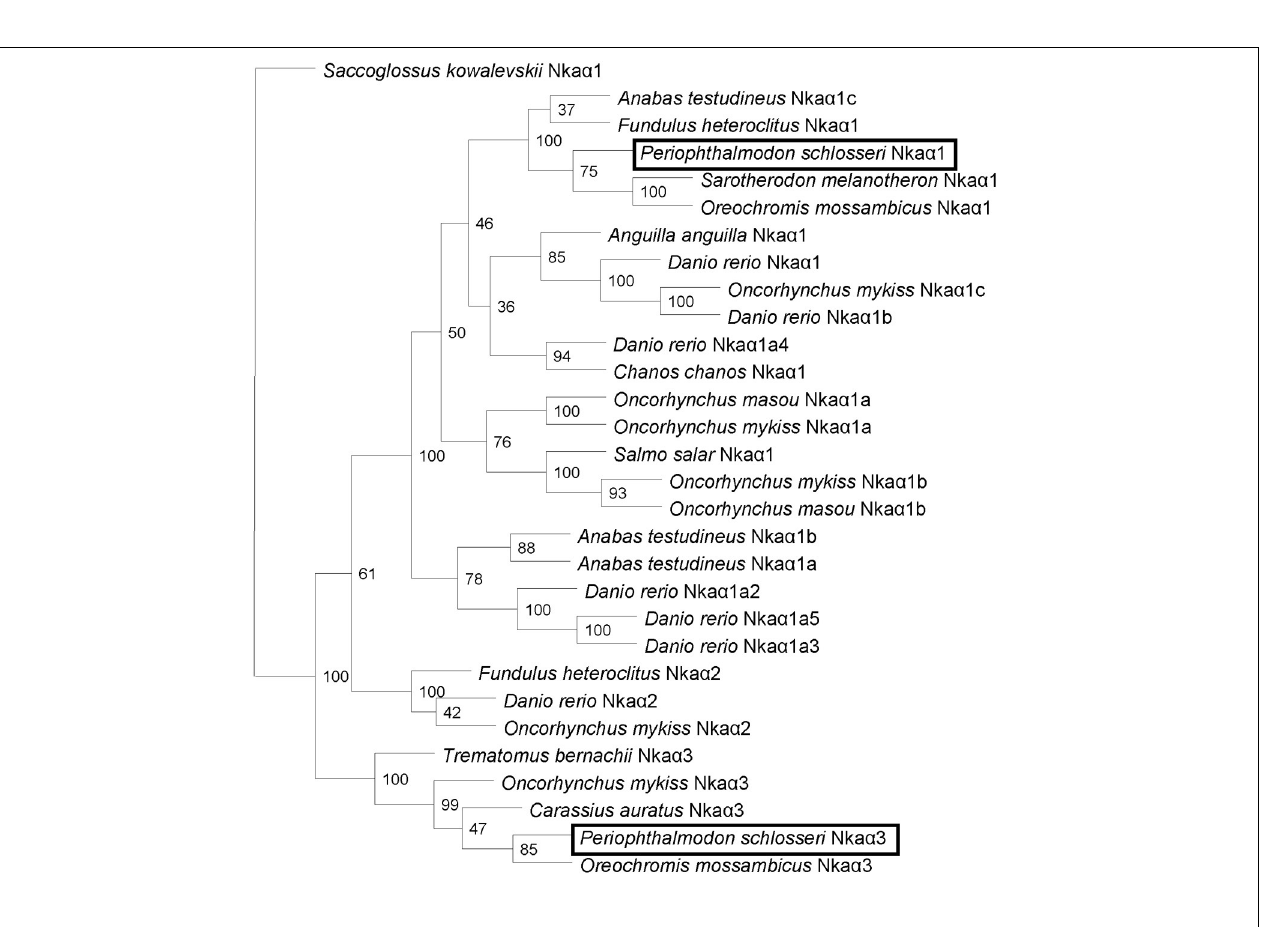
schlosseri and Nka α 1, Nka α 2 and Nka α 3 of selected teleost species. Numbers presented at each branch point represent bootstrap values from 100 replicates. Saccoglossus kowalevskii Nka is used as an